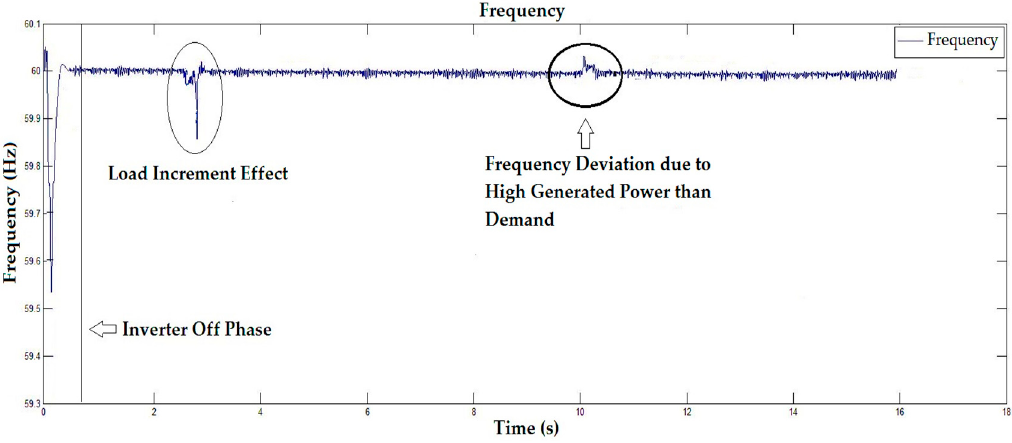
Figure 18 . Frequency response in system overloading mode.